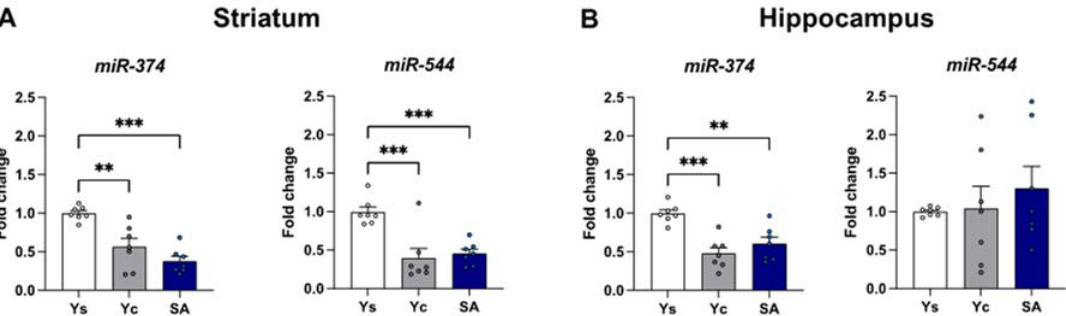
Figure 7. The expression of miR-374 and miR-544 in the striatum ( A ) and hippocampus ( B ) after 14 days of cocaine self-administration (0.5 mg/kg/inf.). n = 7 rats/group. Significance was determined using a one-way ANOVA and the post hoc Dunnett’s test. ** p < 0.01, *** p < 0.001 versus the yoked saline (Ys) control group. SA: cocaine self-administration group; Yc: yoked cocaine